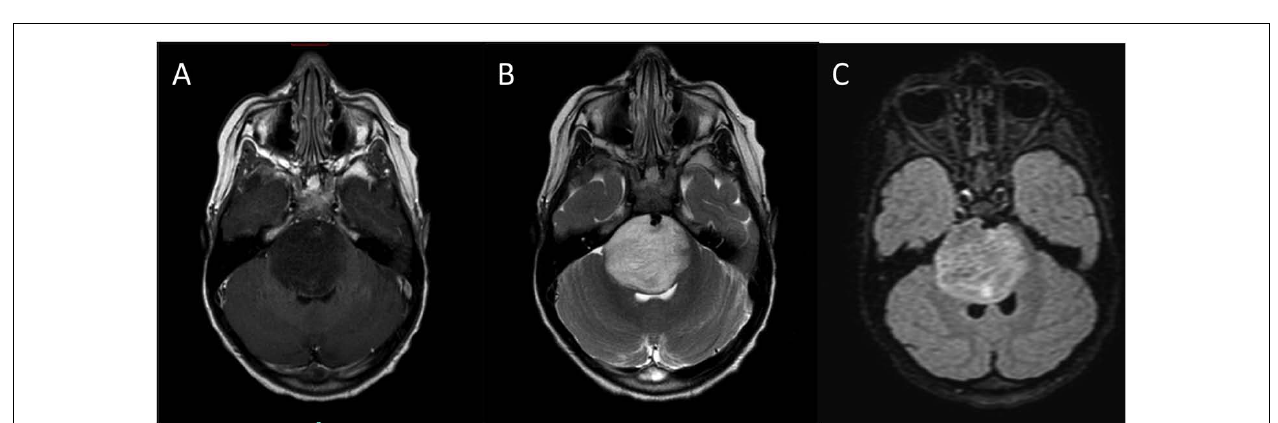
FIGURE 2 |Typical MRI appearance of DIPG. (A) T1-weighted post contrast, (B) T2-weighted, (C) FLAIR.